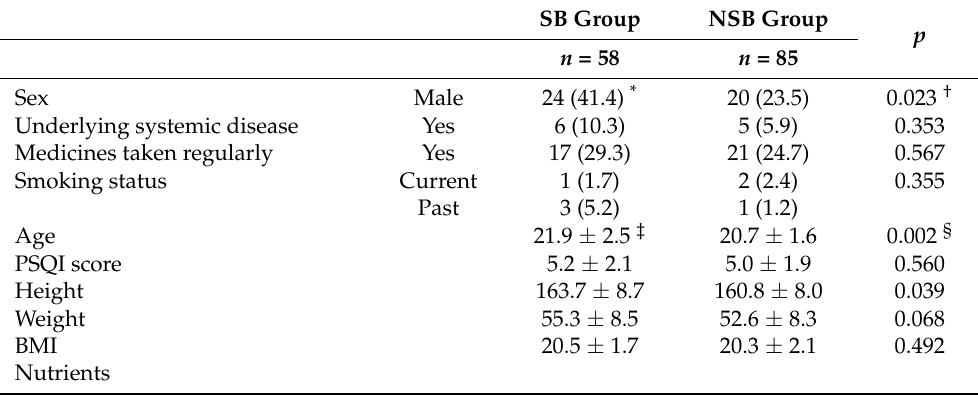
Table 1. Differences in parameters between the sleep bruxism and non-sleep bruxism